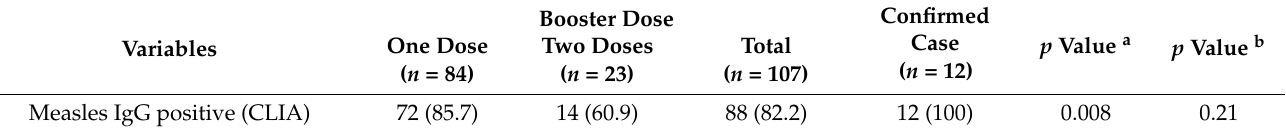
Table 3. Comparison of measles-specific IgG response of each group after one or two booster doses of MMR vaccine or laboratory-confirmed measles infection among young, seronegative healthcare